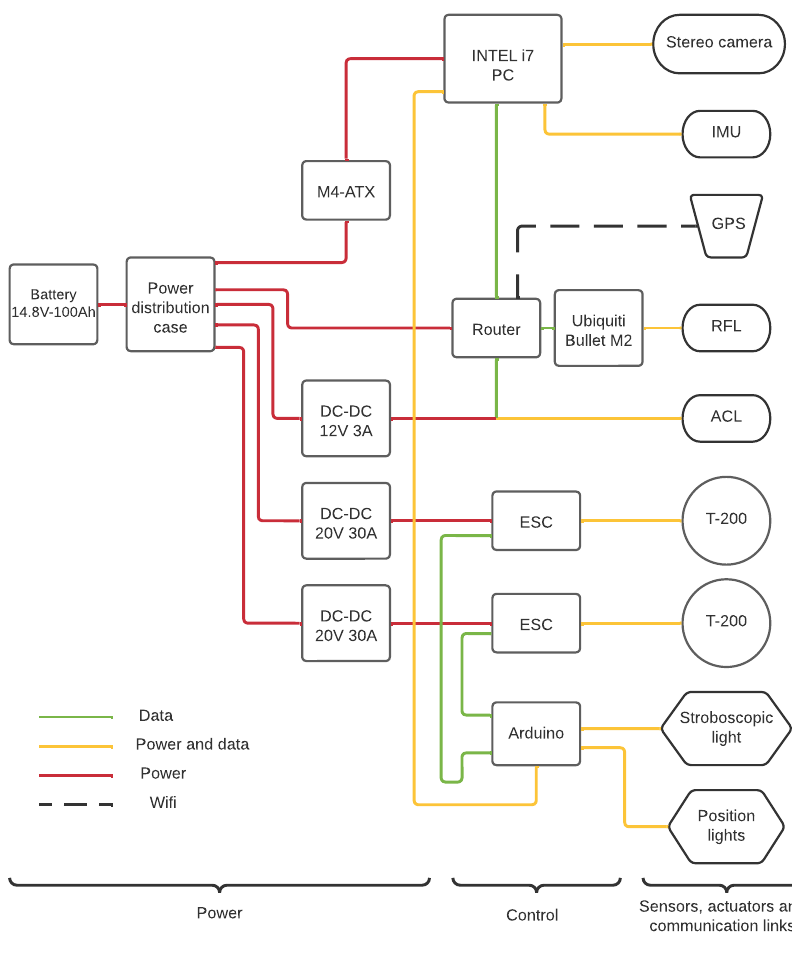
Figure 2. Xiroi II onboard electronics. Red lines represents the power wires, green lines represents the data wires, yellow lines represents data and power wires, and black stripped lines represents a WiFi